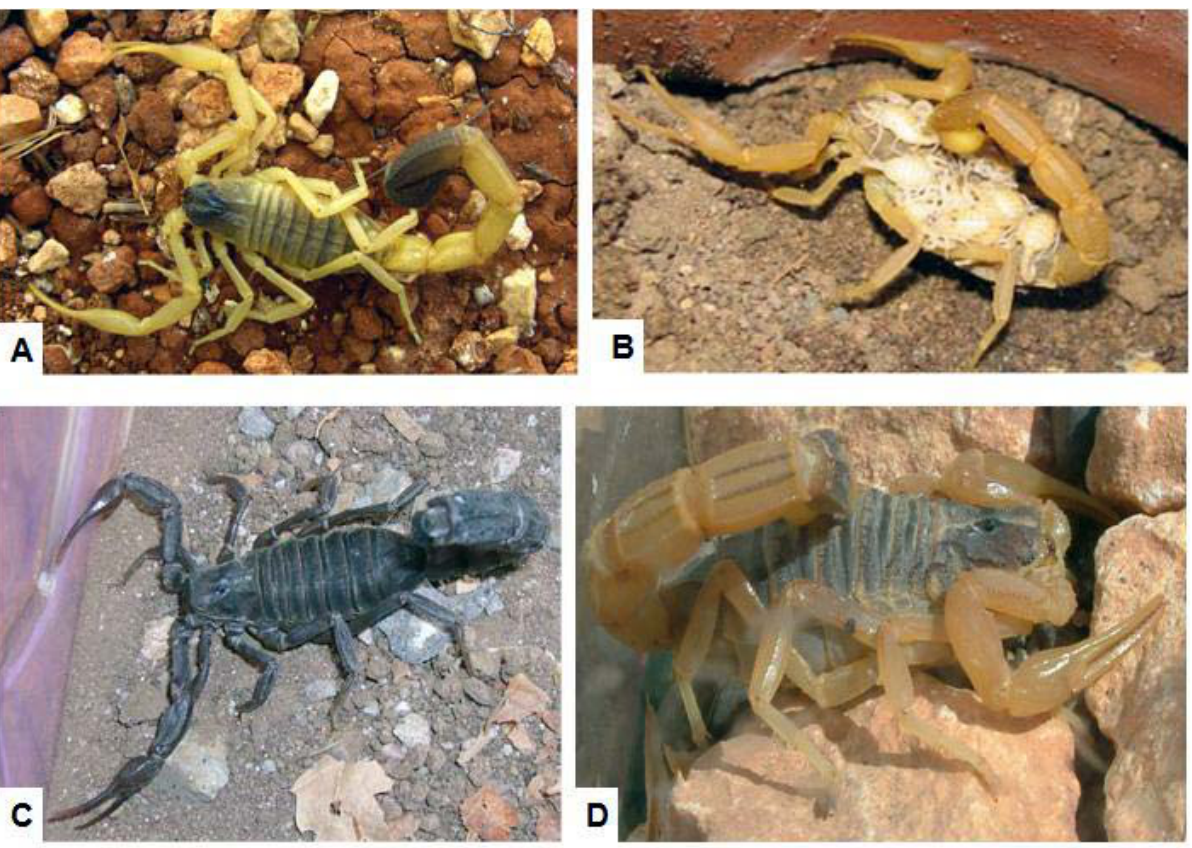
Figure 1. Medically important scorpion species in Turkey. ( A ) Hottentotta saulcyi , ( B ) Mesobuthus gibbosus , ( C ) Androctonus crassicauda and ( D ) Leiurus abdullahbayrami